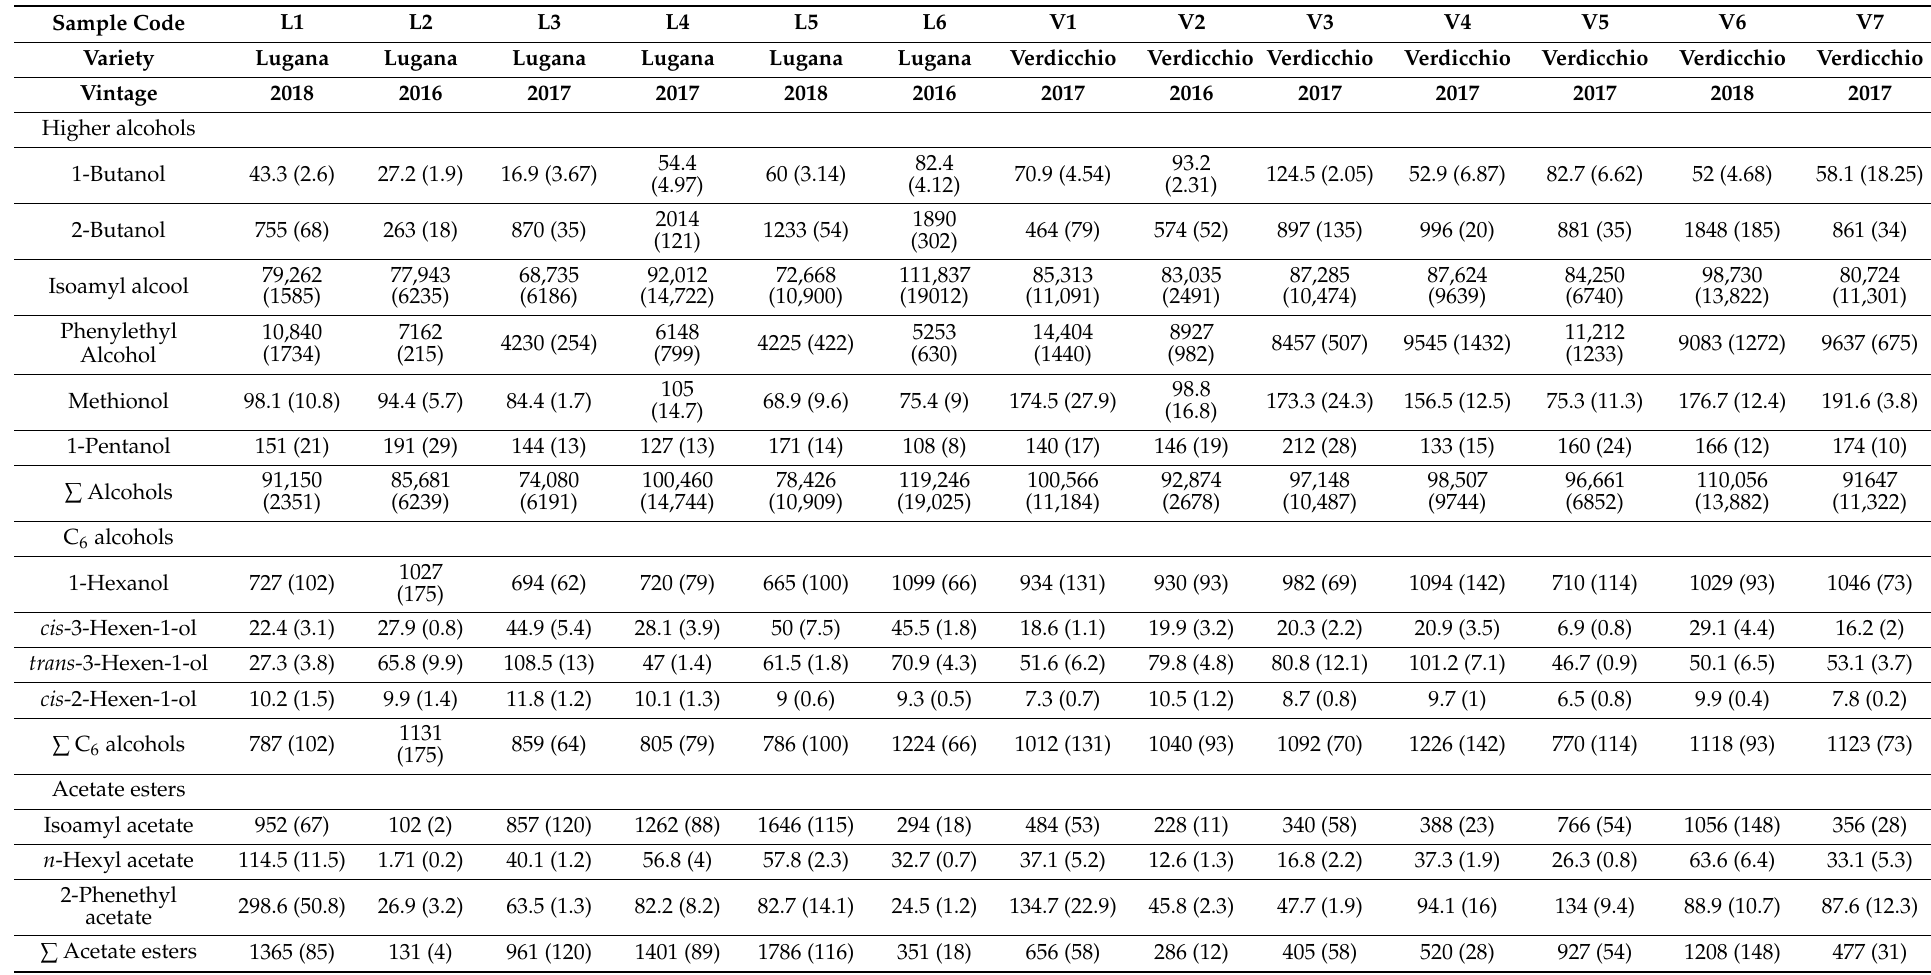
Table 1. Volatile compounds mean concentration ( µ g/L) and standard deviation (in brackets) of Lugana and Verdicchio